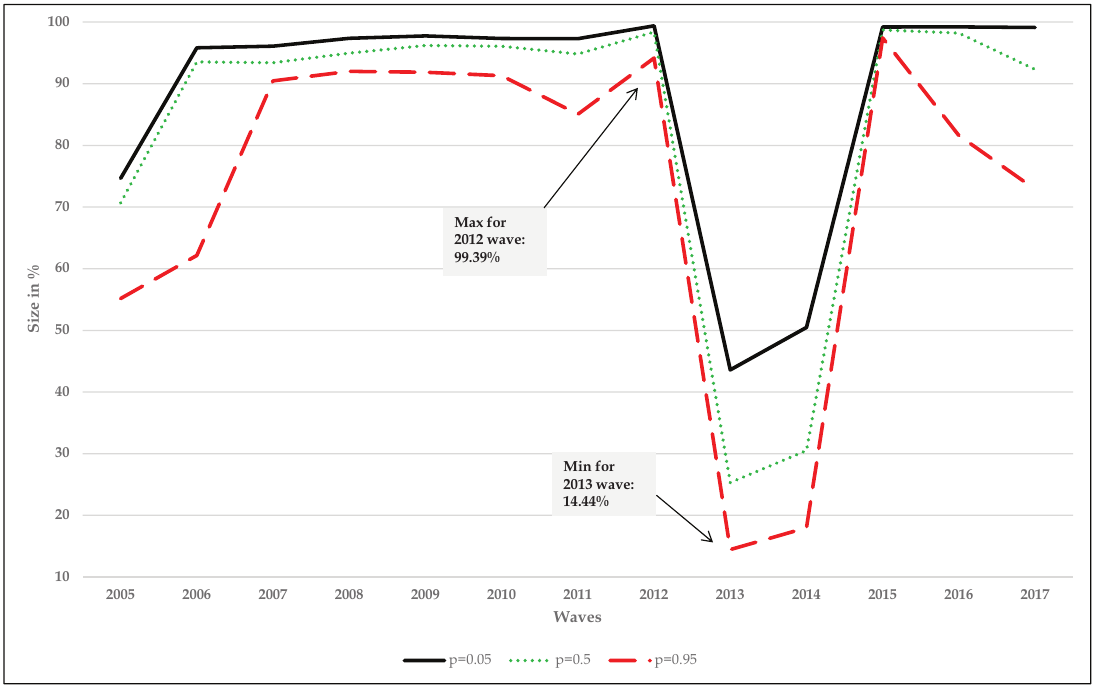
Figure 2. Size of the optimal subsamples for several p